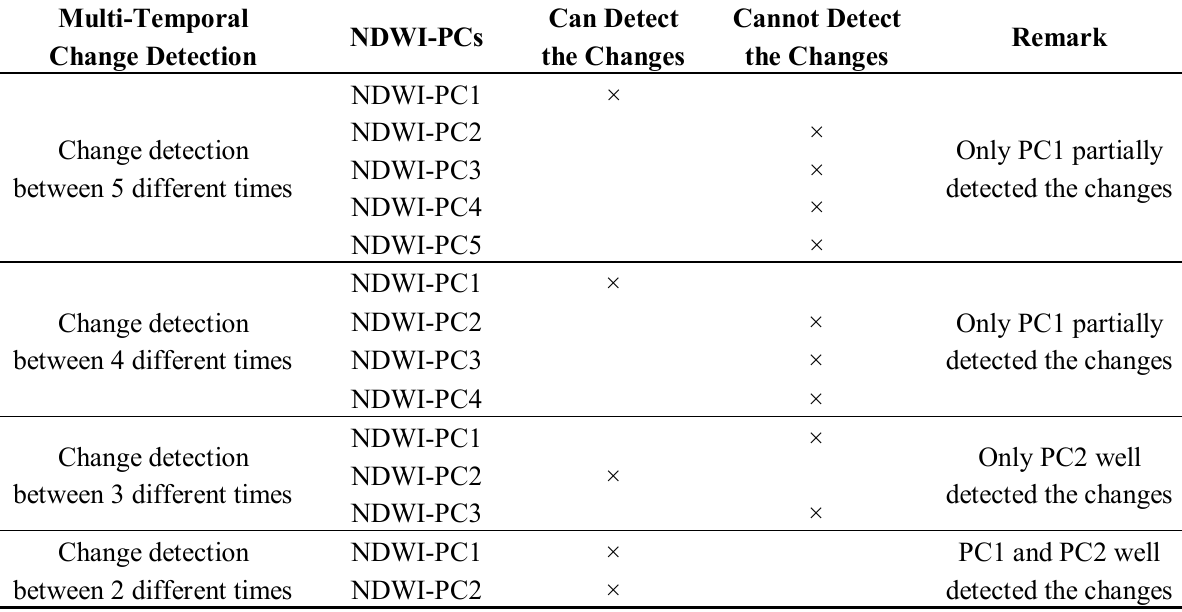
Table 6. Application of NDWI-PCs for multi-temporal change